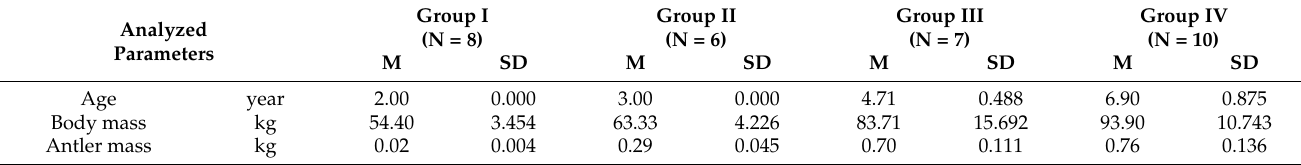
Table 1. Mean (M) and standard deviation (SD) age, body mass and antler mass of four groups of farmed fallow